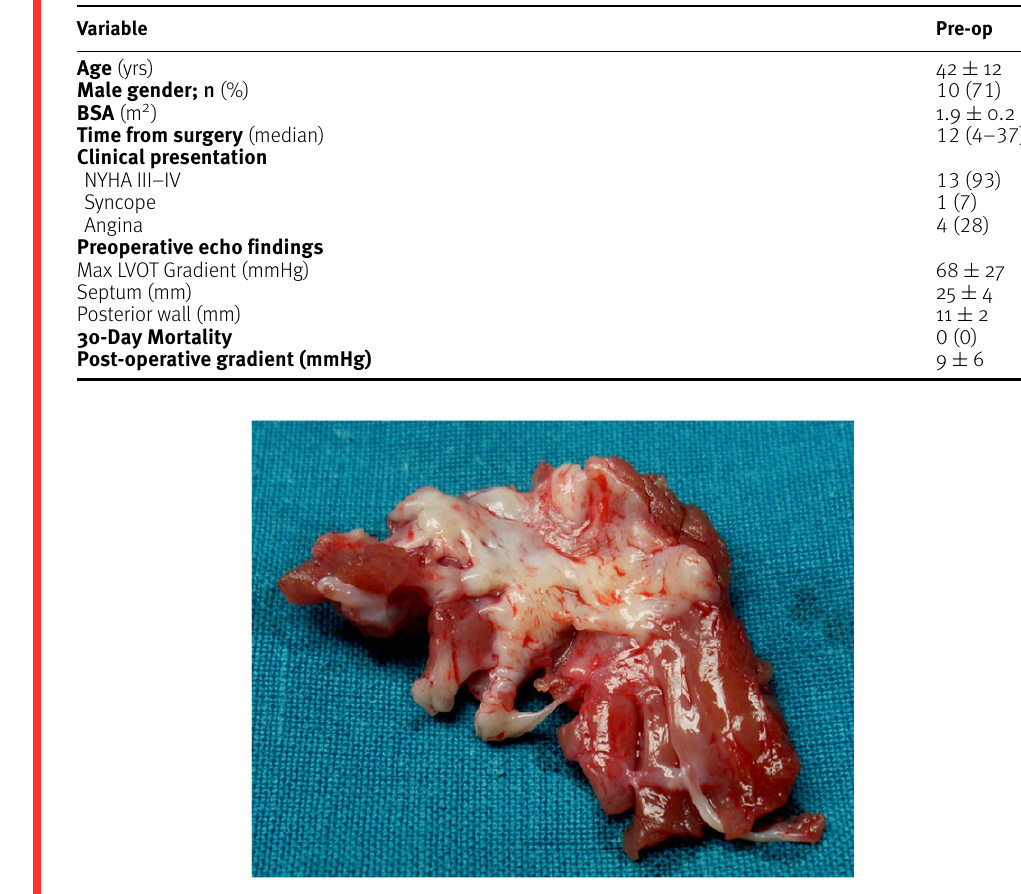
Figure 1. Myectomy specimen illustrating the extent of the resected muscle which includes the area of subendocardial fibrosis on the septum and three muscle bands extending into the midventricular